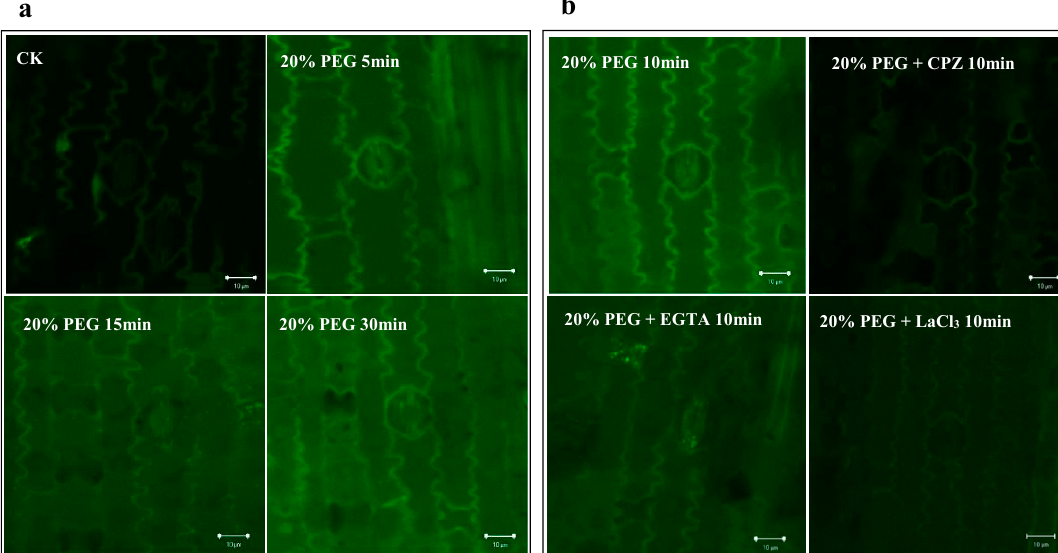
Figure 9. H 2 O 2 fluorescence in P. edulis seedling leaves under drought stress. The green fluorescence intensity in the figure represents concentration of hydrogen peroxide, with more fluorescence indicating a higher concentration of H 2 O 2 . ( a ) H 2 O 2 fluorescence localization at different treatment times (5 min, 15 min, and 30 min) using 20% PEG-induced drought stress. ( b ) The samples were treated with different Ca 2+ inhibitors (CPZ, EGTA, and LaCl 3 ) for 10 minutes under 20% PEG-induced drought stress.